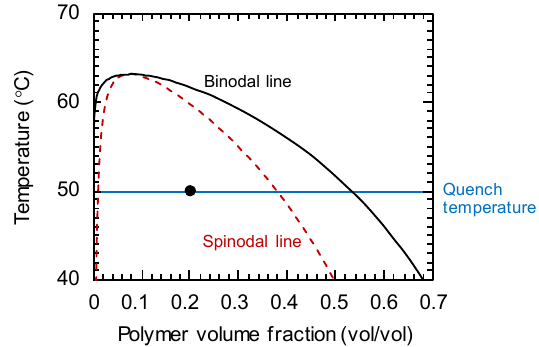
Figure 2. Phase diagram of PMMA/cyclohexanol system. The solid and dashed lines represent the binodal and spinodal lines, respectively. The condition targeted in this study is plotted in this dia- gram.